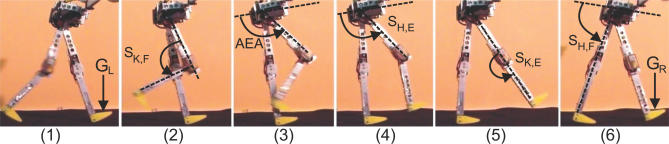
Series of Frames of One Walking StepAt the time of frame (3), the stretch receptor (AEA signal) of the swing leg is activated, which triggers the extensor of the knee joint in this leg. At the time of frame (6), the swing leg begins to touch the ground. This ground contact signal triggers the hip extensor and knee flexor of the stance leg, as well as the hip flexor and the knee extensor of the swing leg. Thus, the swing leg and the stance leg swap their roles thereafter.